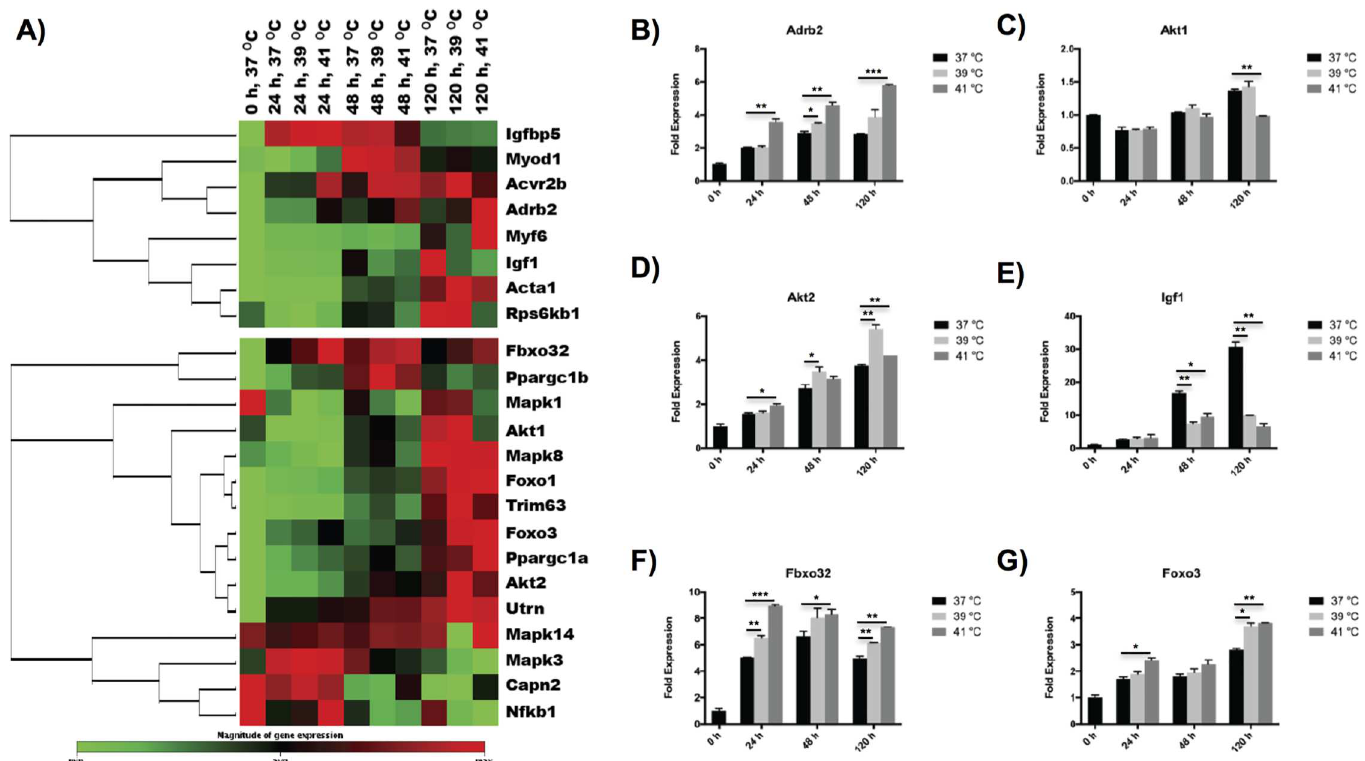
Fig 4. Effects of hyperthermia treatment on hypertrophy/atrophy of C2C12 myoblasts during myogenic differentiation. (A) Clustergram of hypertrophy(top) and atrophy (bottom) genes showingtime- and temperature-dependenceson hyperthermia treatment during myogenicdifferentiation. (B-G) Characteristic hypertrophy/atrophy genes represented in bar figures. The error bars in (B-G) represent the standard deviationof the mean, and the myotubes cultured at 37˚C were used as a control. All statistical differences against the control are indicated. * p < 0.05, ** p < 0.01, *** p < 0.001.